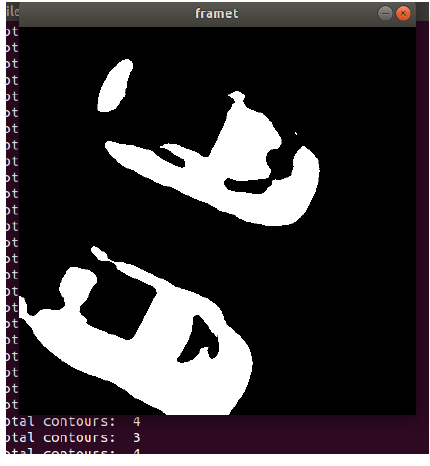
Figure 6. Threshold Image The above image is the threshold picture of the vehicles detected by our system using Otsu thresholding.